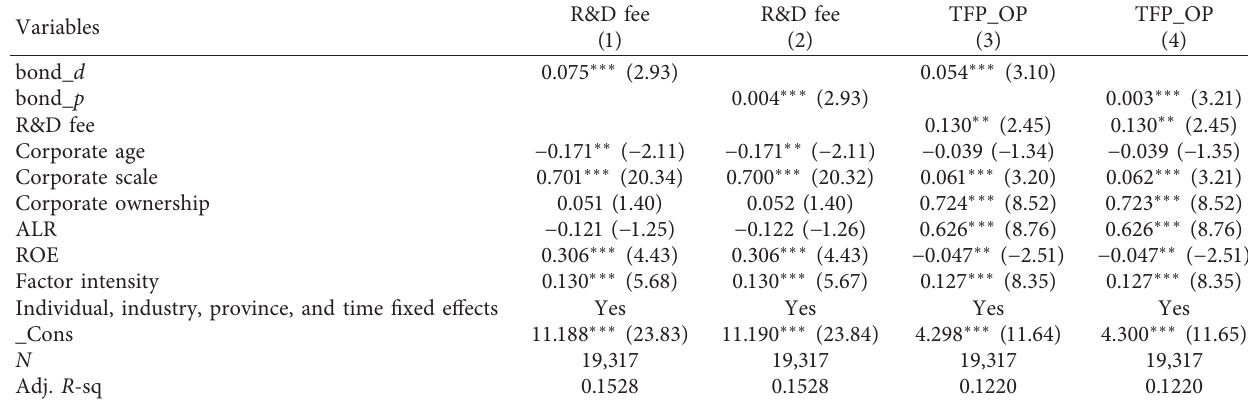
Table 4: Action mechanism of bond financing on corporate